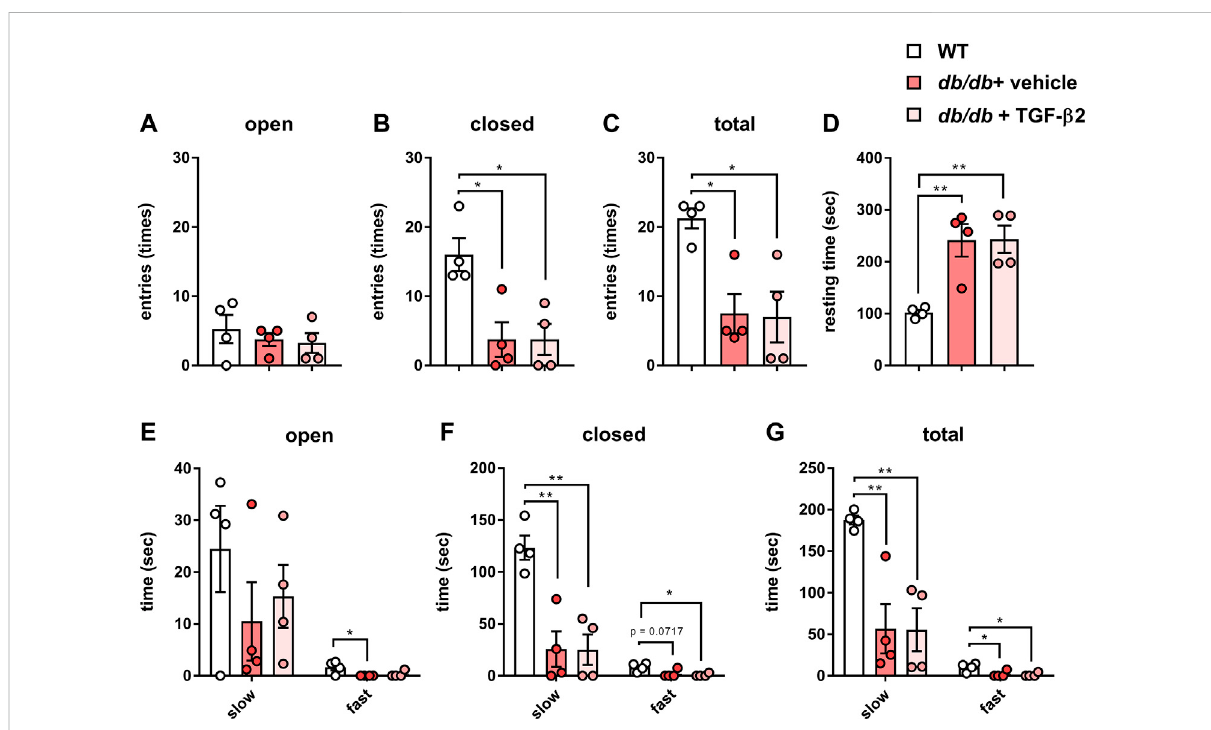
FIGURE 2 TGF- β 2infusionhasnoeffectonthelowlocomotoractivityof db/db mice.Numbersof (A) open, (B) closed,and (C) totalarmentries (D) Resting timeandtimespentonslowandfastmovementinthe (E) openarms, (F) closedarms,and (G) bothopenandclosedarmsforthe db/db +vehicleand db/db + TGF- β 2 mice. Data are presented as the mean ± SE ( n = 4/group). The dots represent individual data points. ** p < 0.01; * p <